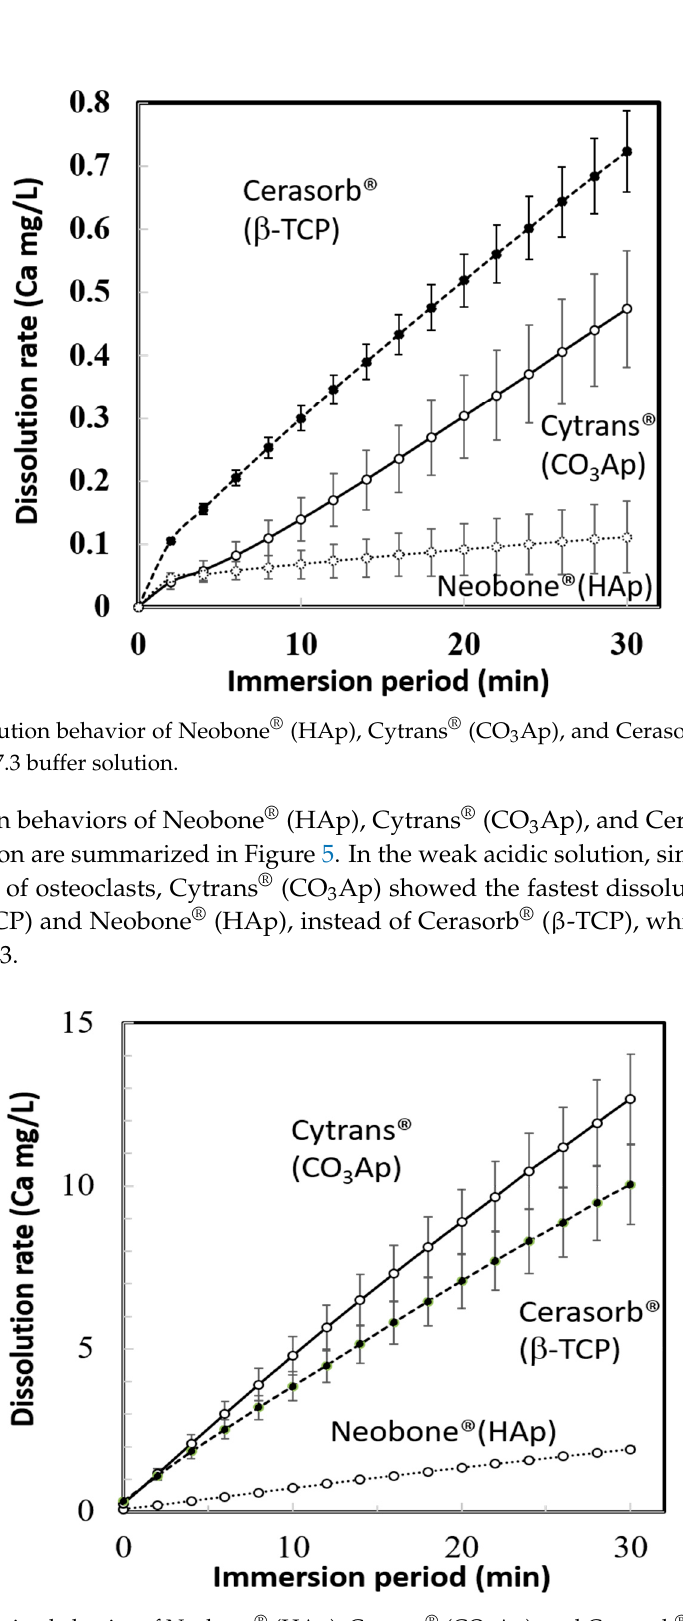
Figure 5. Dissolution behavior of Neobone ® (HAp), Cytrans ® (CO 3 Ap), and Cerasorb ® ( β -TCP) in pH